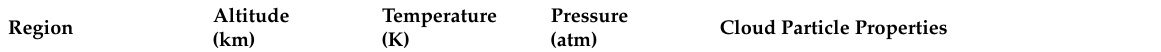
Table 1. Distribution of the Venusian cloud particles. Data originally from [32,33], based on review of the data in [23]. (1)—Mode 1 particles; (2)—Mode 2 particles; (3)—Mode 3